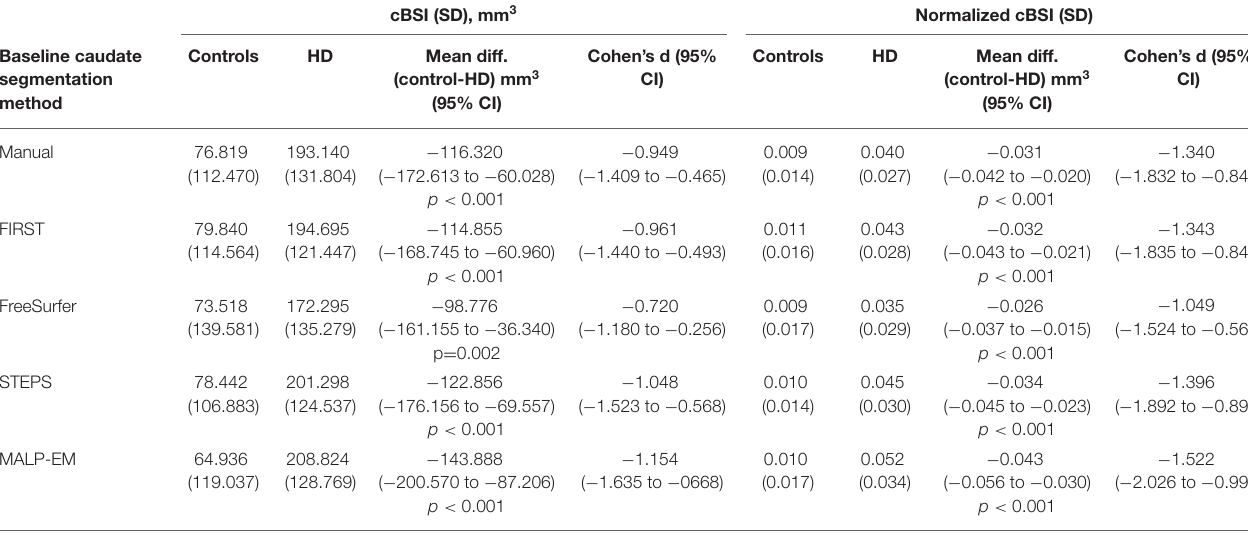
TABLE 3 | Group comparisons of cBSI and normalized cBSI outputs by baseline caudate segmentation